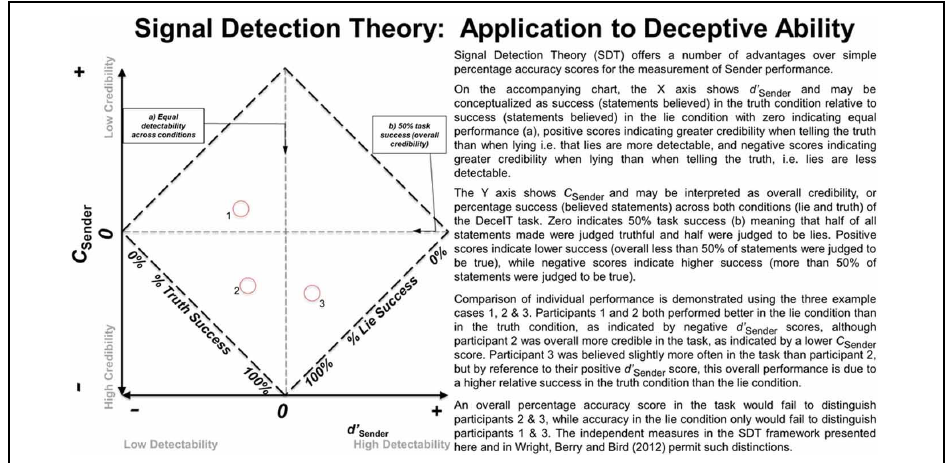
FIGURE 1 | An overview of the application of Signal Detection Theory (SDT) to the Sender role and its